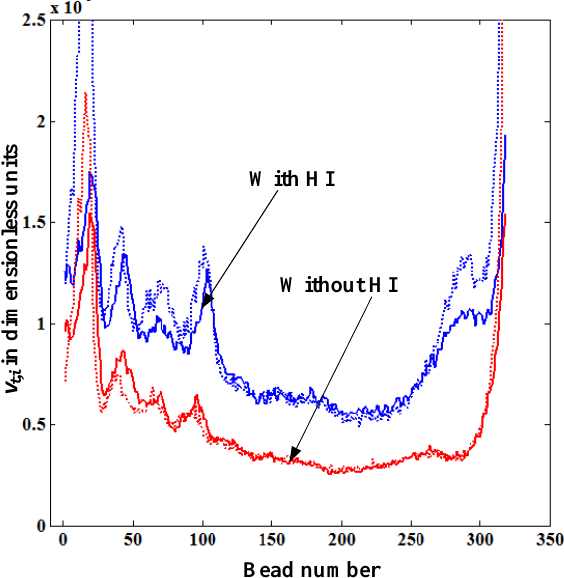
Figure 6. Variation of the translocation velocity of each bead v the cases with and without HI for the polymer length N = 320. The dotted lines represent the values v calculated from Equation (5). t , i